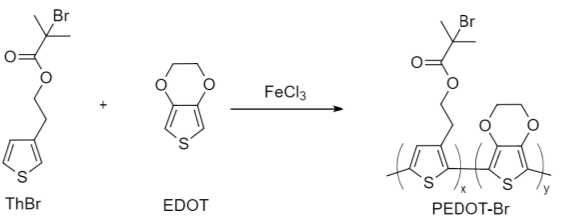
Figure 2. Chemical oxidative polymerization of ThBr and EDOT monomers.